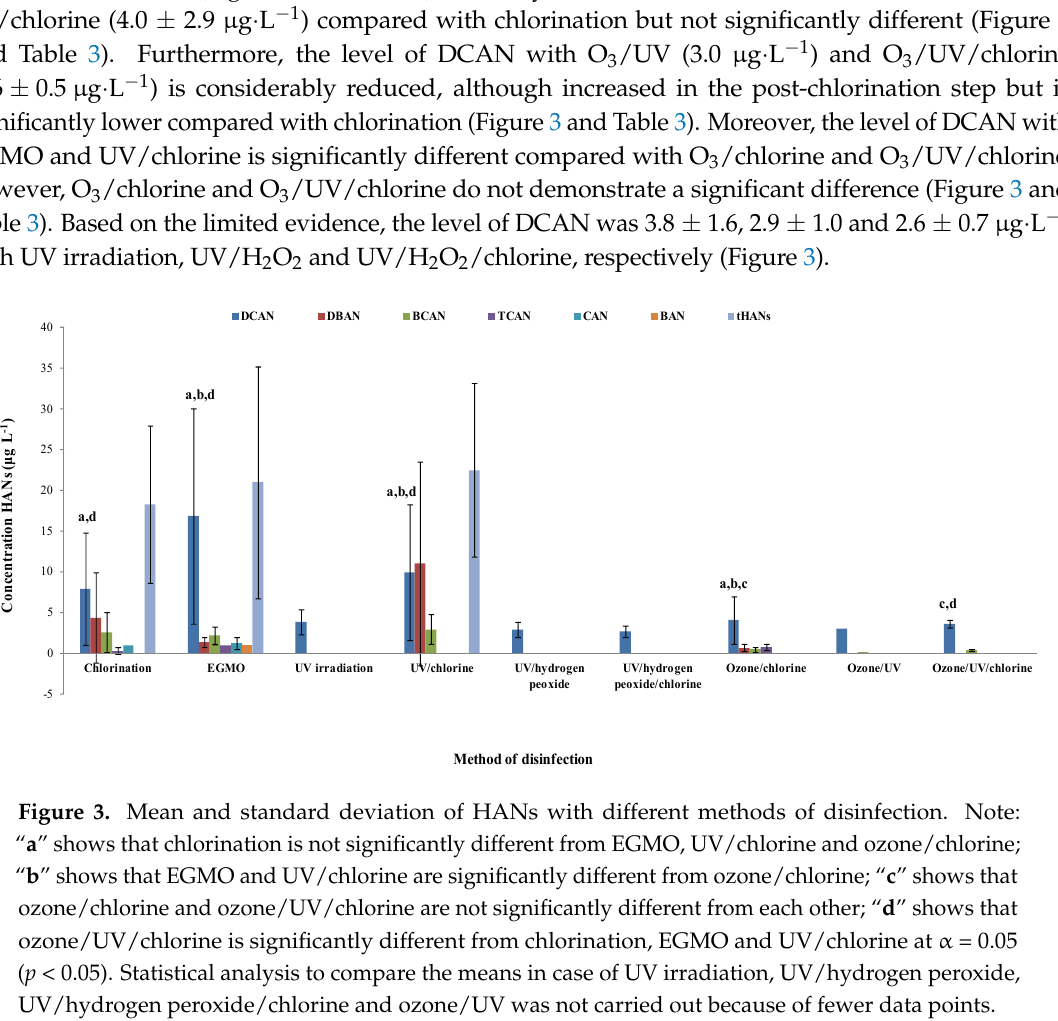
Figure 4. Mean and standard deviation of THAs with different methods of disinfection. Note: “ a ” shows that chlorination and UV/chlorine are not significantly different at α = 0.05 ( p < 0.05). Statistical analysis to compare the means in the case of ozone/chlorine was not carried out because of fewer data points.